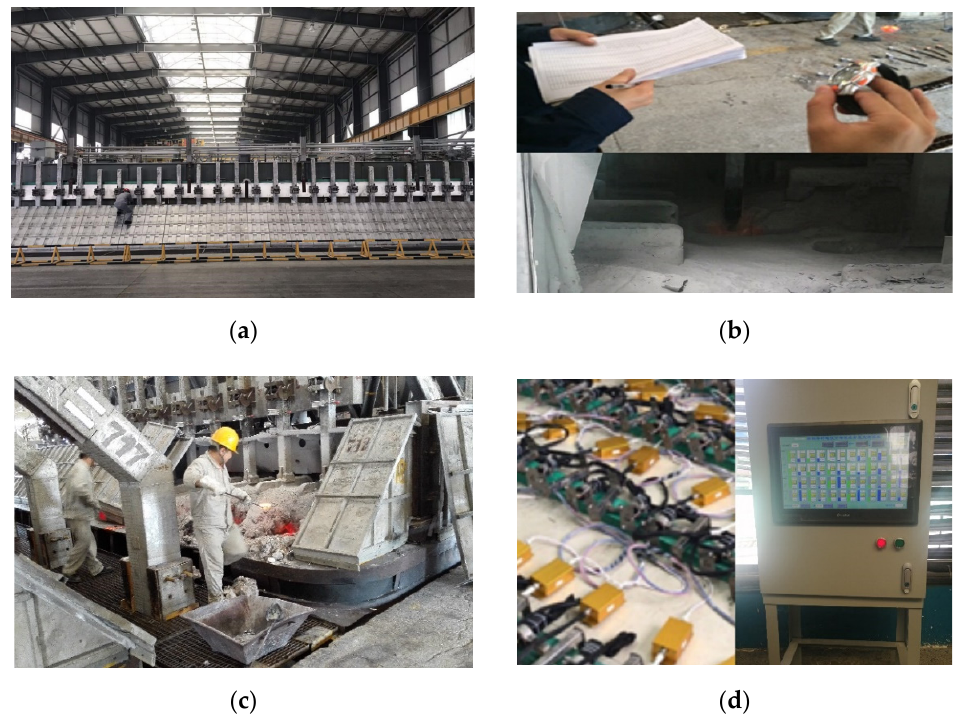
Figure 6. Field collection diagram: ( a ) actual working area of modern aluminum electrolysis; ( b ) data acquisition diagram of feeding interval; ( c ) scoop out the electrolyte diagram; and ( d ) distributed current acquisition diagram.